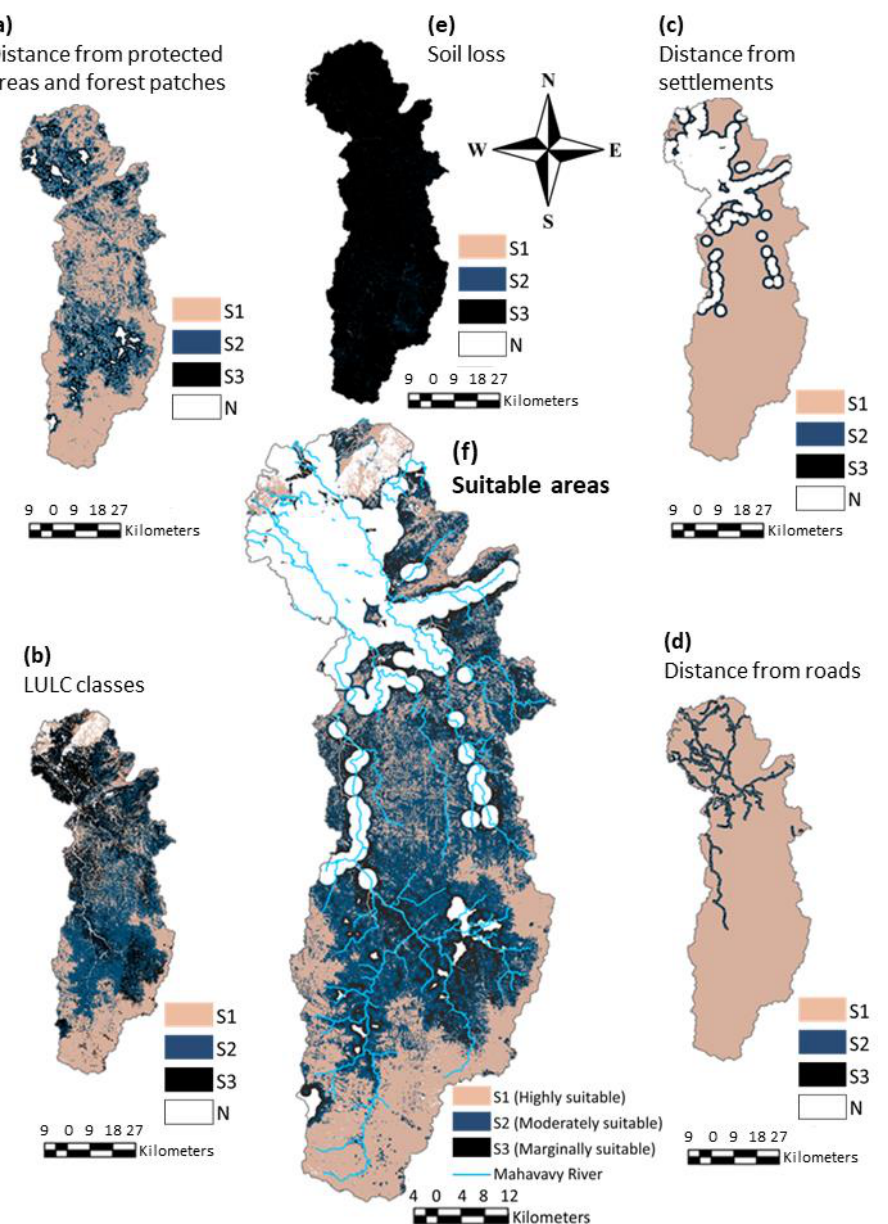
Figure 7. Reclassification of each criterion for land suitability analysis ( a ) distance from protected areas and forest patches, ( b ) LULC, ( c ) distance from settlements, ( d ) distance from roads, ( e ) soil loss, and ( f ) potential suitable areas for restoration in the Mahavavy watershed.